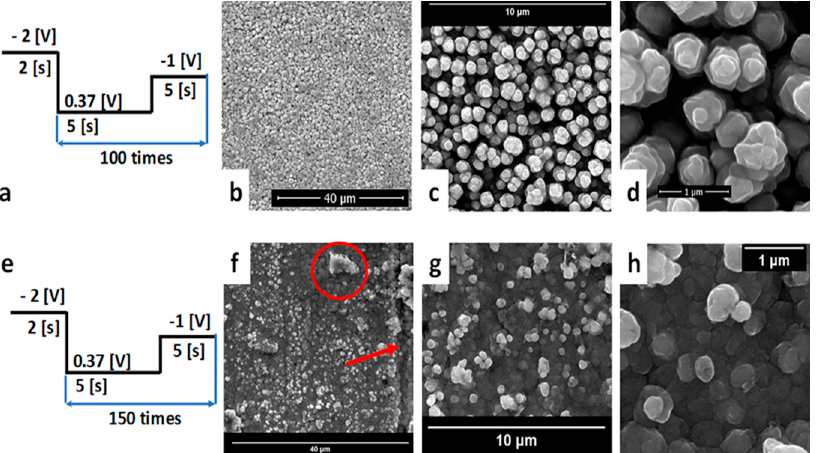
Figure 5. Copper pulsed electrodeposition at 100 and 150 pulses. Schematic representation of applied pulses ( a , e ) and top view SEM images at different magnifications ( b – d , f – h ).